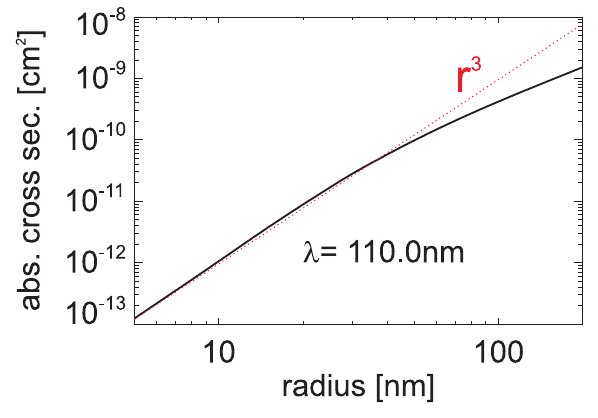
Fig. 7. Absorption cross section of ice particles as a function of radius for a wavelength of 110nm (black line). The red line in- dicates the Rayleigh limit in which the absorption cross section is proportional to the volume of the particles.